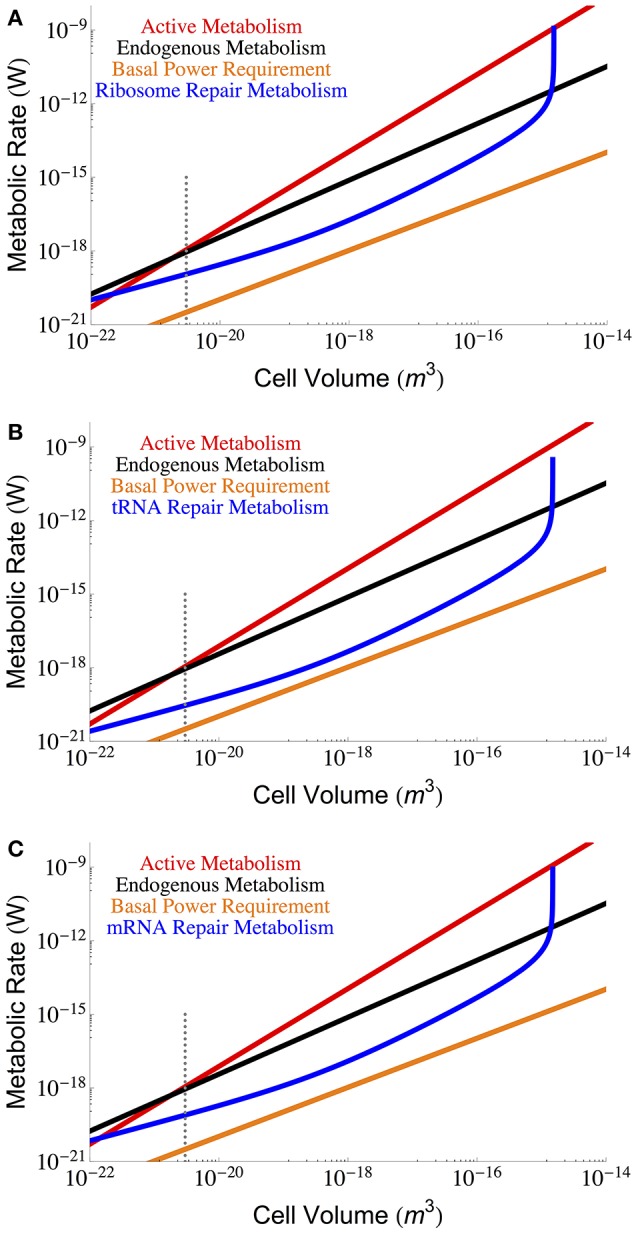
The overall scaling of total (red) and maintenance (black) metabolism along with predictions for repair cost of (A) ribosomes, (B) tRNA, and (C) mRNA. In an attempt to capture less active rates of repair we used the degradation rates reported in Defoiche et al. (2009), combined with reported polymerization costs (Neidhardt and Ingraham, 1990; Russell and Cook, 1995; Pramanik and Keasling, 1997; Haynie, 2001; Lever et al., 2015; Lynch and Marinov, 2015; see Methods Section for a longer discussion). The dotted gray line indicates the smallest known bacterial cells (Luef et al., 2015; Kempes et al., 2016).